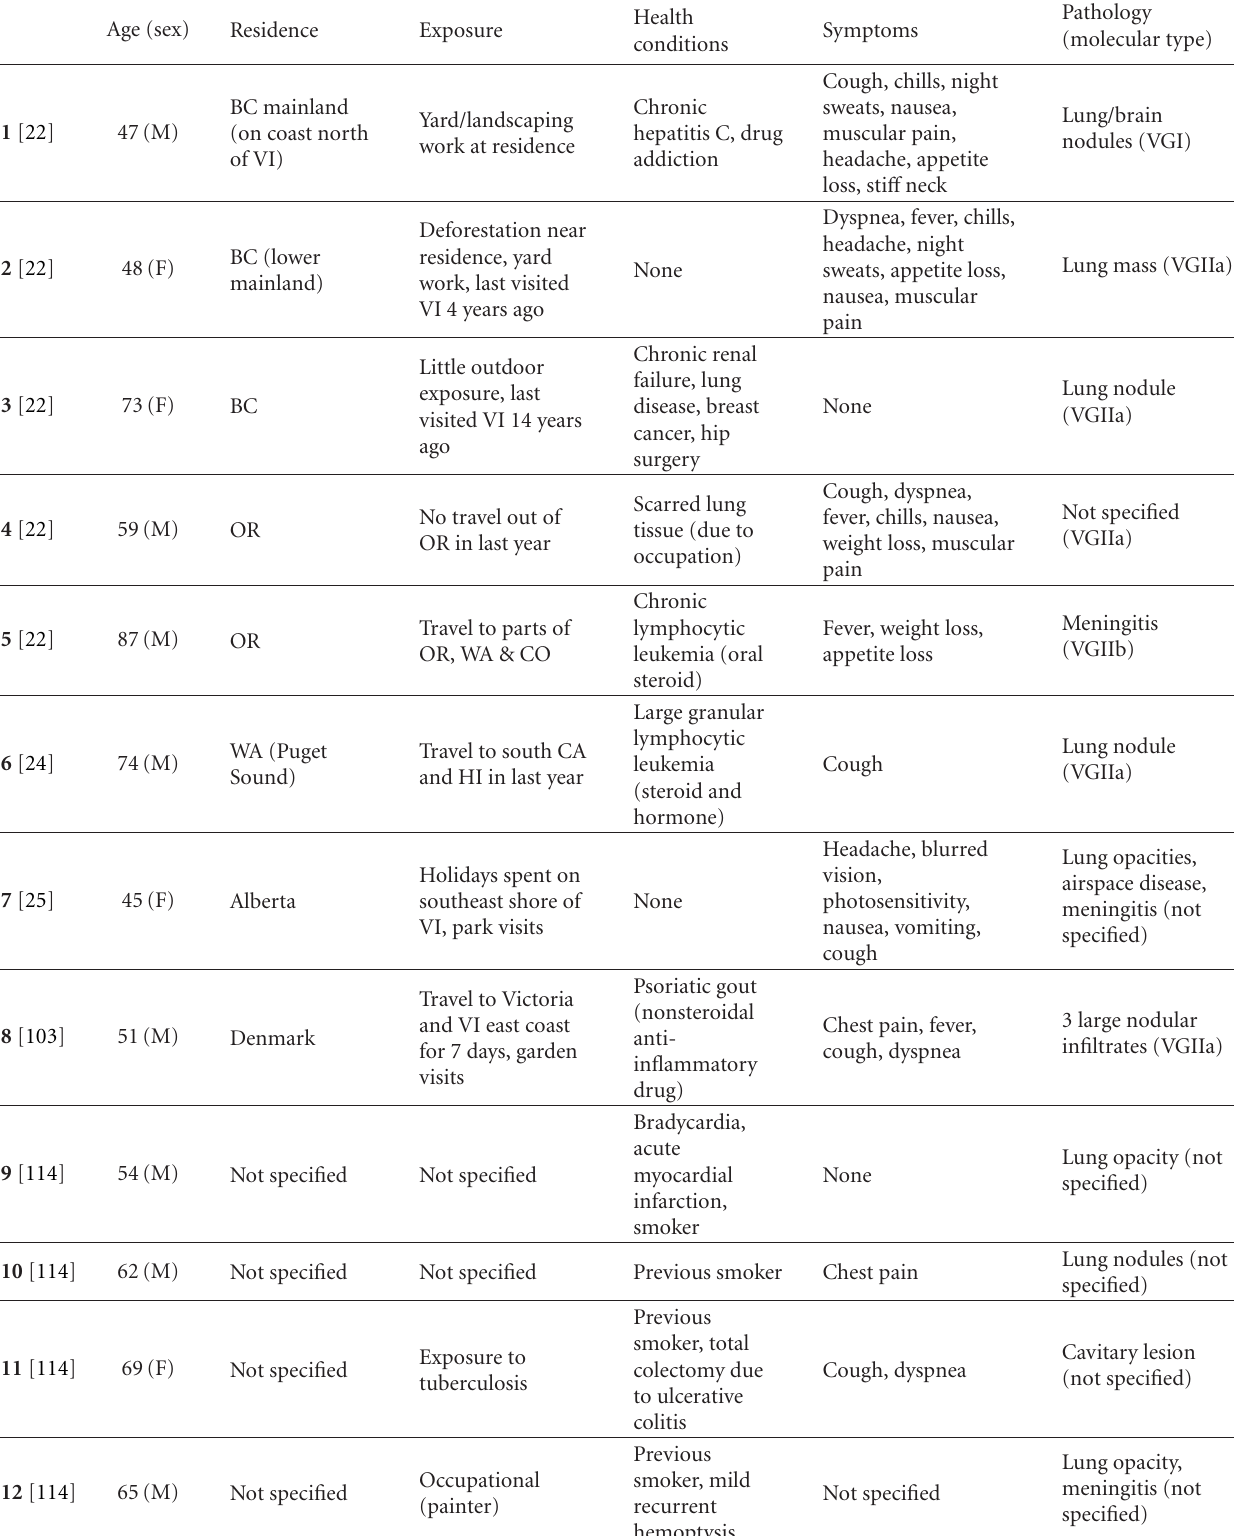
Table 2: Summary of case reports of C. gattii